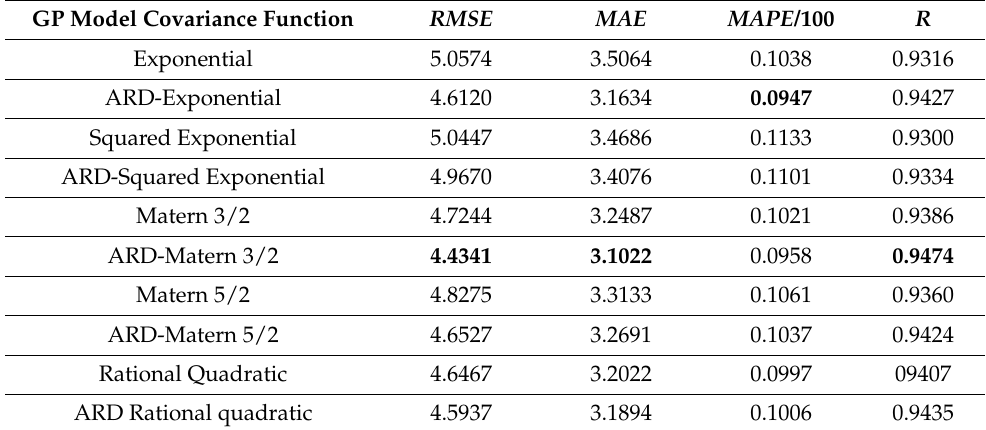
Table 9. Comparative analysis of results of GPR with various covariance functions.